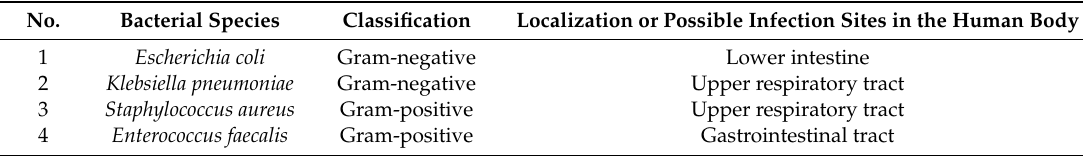
Table 5. Species of bacteria used for the anti-bacterial study.